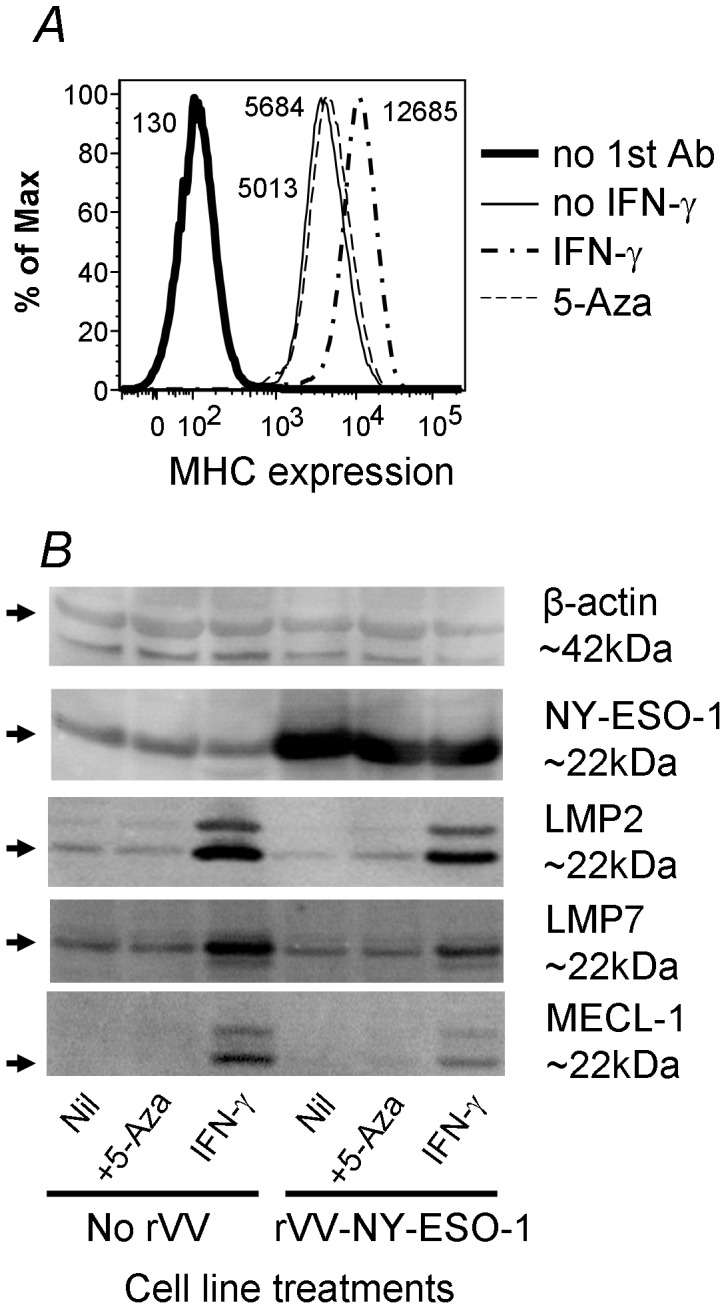
IFN-γ-induction induces immunoproteasome and rVV-NY-ESO-1 infection significantly increases NY-ESO-1 expression in tumor cells.Tumor cell line, SK-MEL-8, was treated with either IFN-γ for 48 hrs or 5-aza-dC for 72 hrs. The cells were then stained for their surface class I expression (A). The treated cells were also infected with rVV-NY-ESO-1, or rVV-GFP as a control, for 4 hours. The infected and uninfected cells were then lysed immediately for Western analysis (B). Similar data were obtained from three similar experiments. Note, β-actin was reblotted after stripping the previously bound anti-NY-ESO-1 antibody.